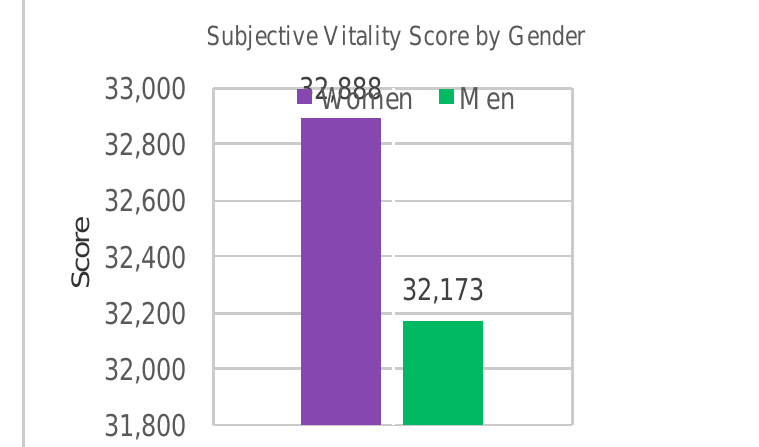
Diagram 2. Subjective vitality scores of pre-service teachers by gender.